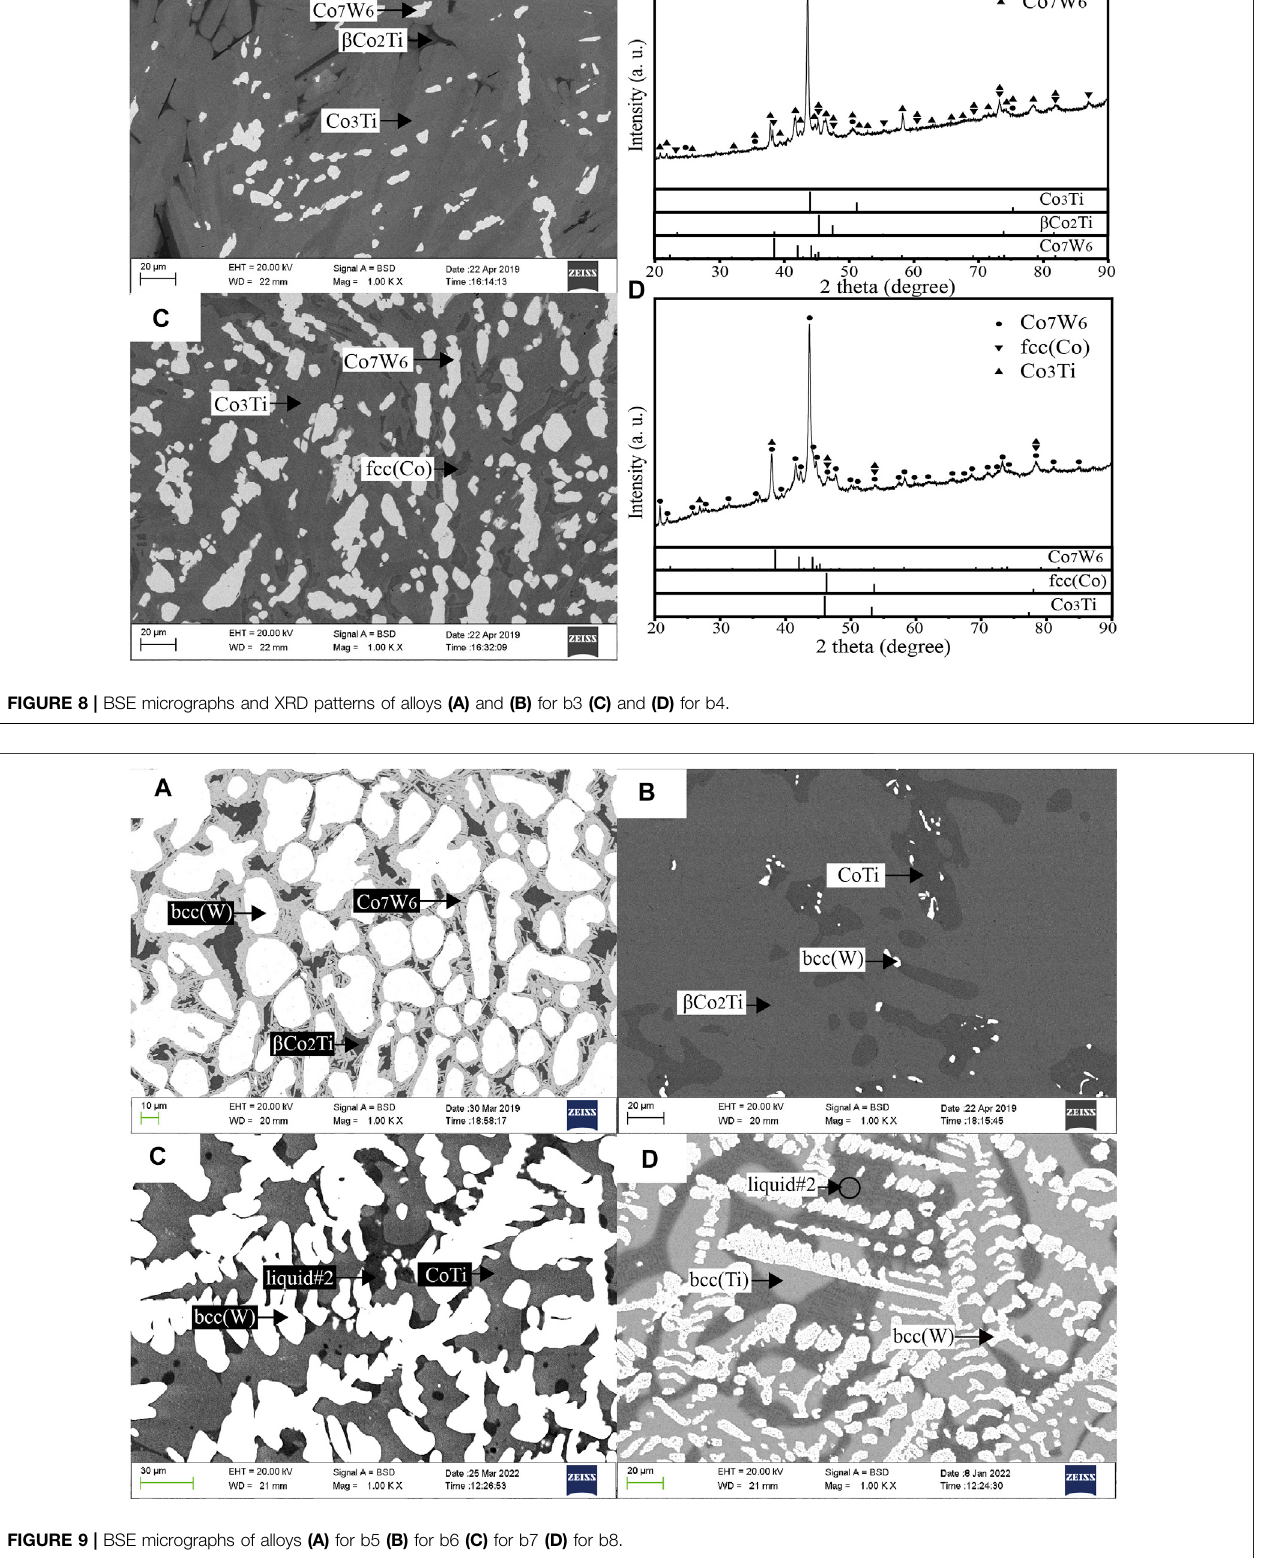
Frontiers in Materials |